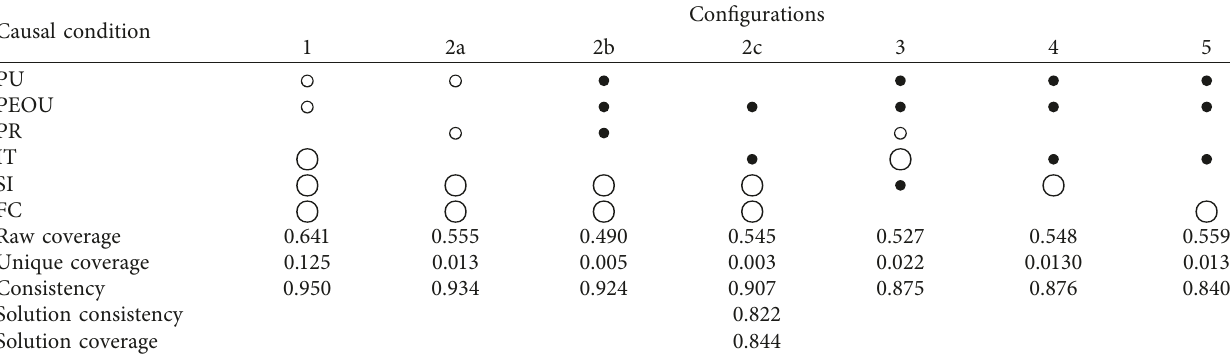
Table 11: Sufficient configurations for the negation of CAVs’